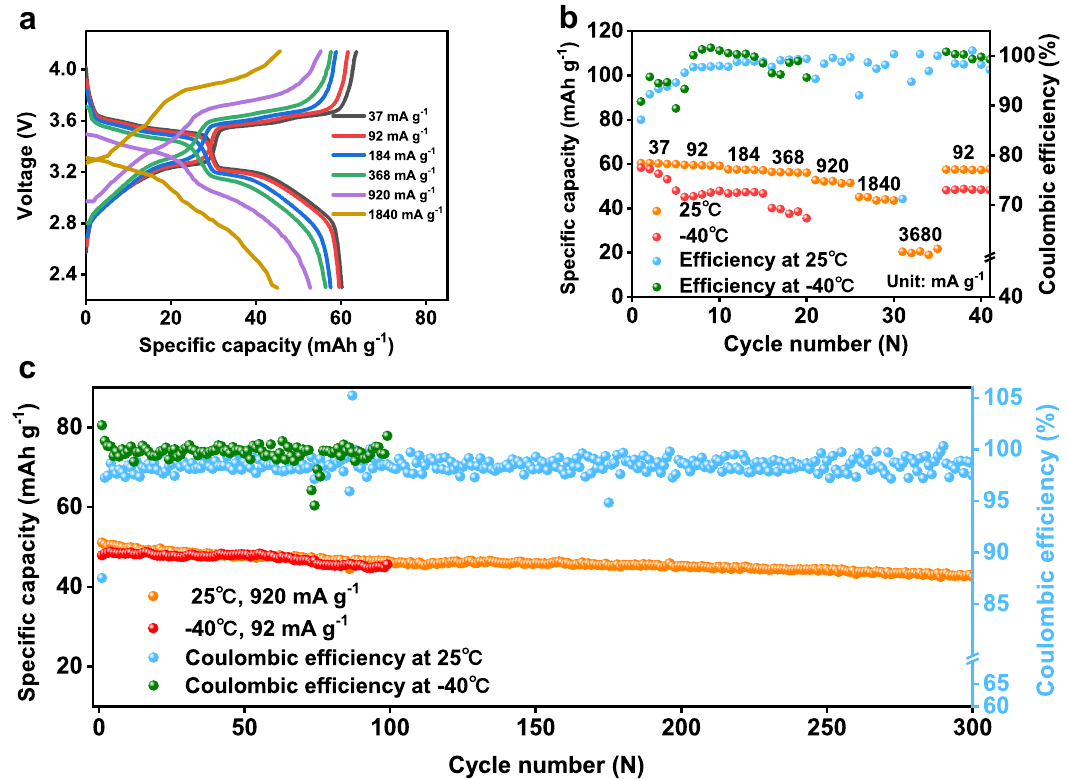
Fig. 7 Electrochemical energy storage performance of the pre-sodiated hard carbon||P2-NaMNNb coin cells at various temperatures. a The electrochemical curves of the full-cell with various speci fi c current. b The rate performance of the full-cell at 25 °C and − 40 °C. c Cycling performance in a rate of 920 mA g − 1 at 25 °C and 92 mA g − 1 at − 40